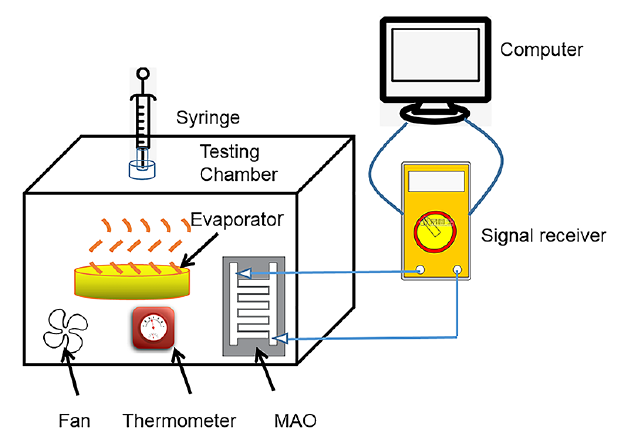
Figure 2. Schematic diagram of experimental setup for testing humidity sensors.